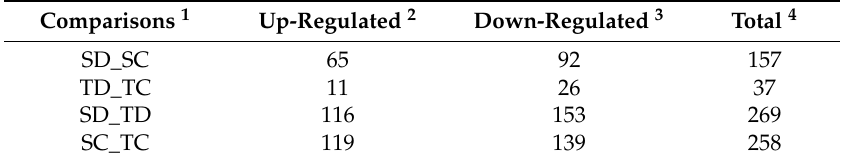
Table 1. Number of differentially abundant proteins (DAPs) identified in each comparison group. Comparisons 1 Up-Regulated 2 Down-Regulated 3 Total 4